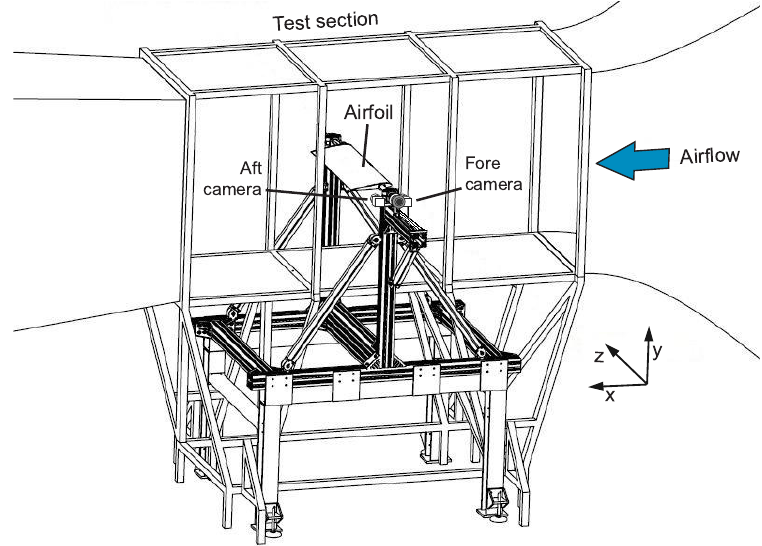
Figure 2. Wind tunnel setup: The laser sheet enters the test section from below.